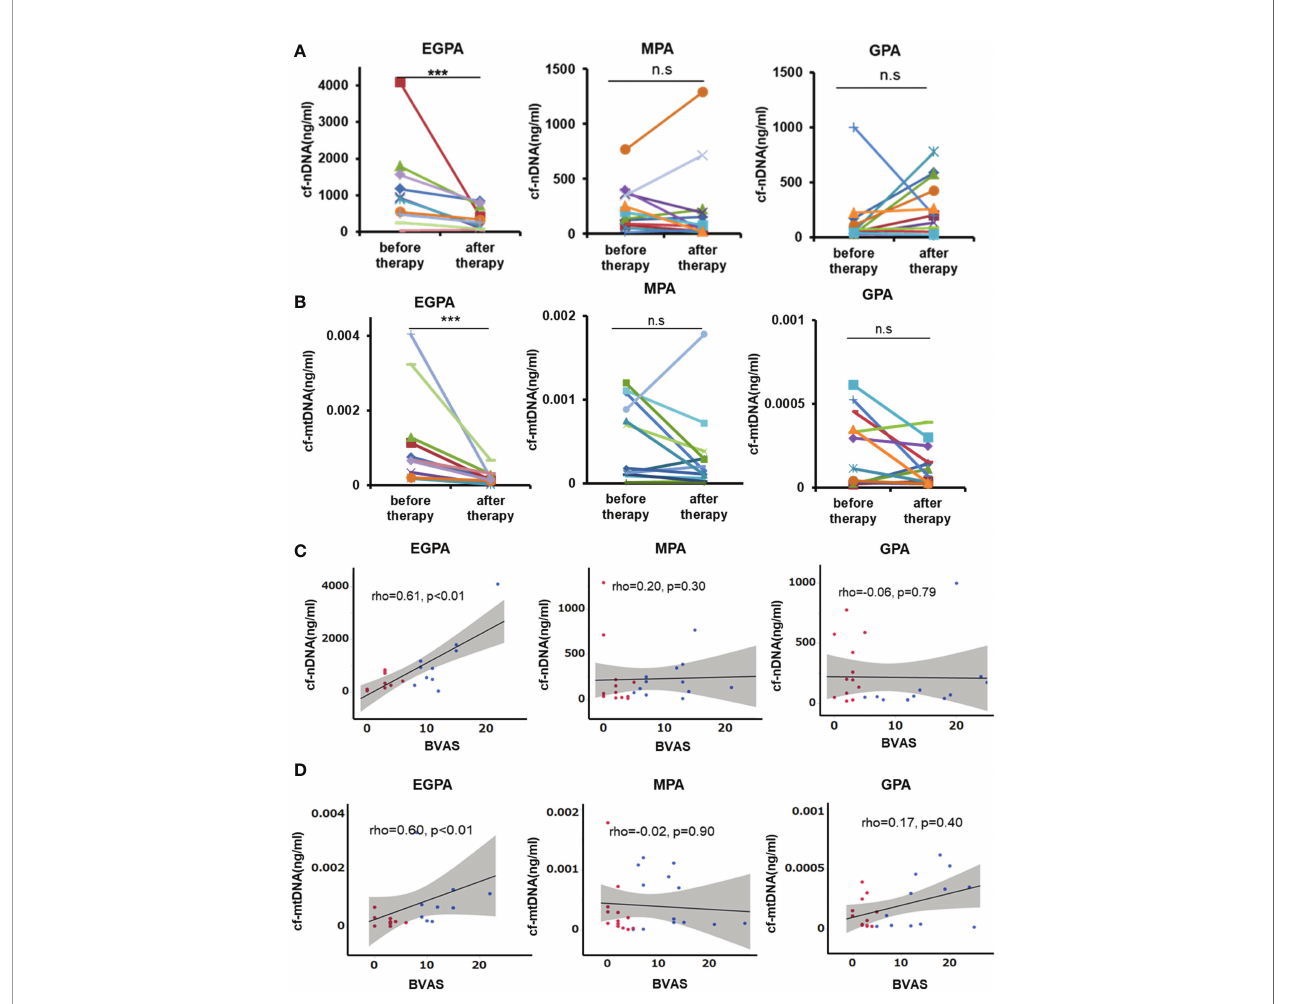
FIGURE 2 | Serum cfDNA levels and disease activity in patients with AAV. (A) Concentrations of cf-nDNA and (B) cf-mtDNA in patients with EGPA, MPA, and GPA before and after immunosuppressive therapy. Same patients connected by lines. EGPA: n=10, MAP: n=13, GPA: n=12, *** P < 0.01, ns, not signi fi cant, Wilcoxon signed rank test. (C) Correlations between serum cf-nDNA and disease activity in patients with AAV. (D) Correlations between serum cf-mtDNA and disease activity in patients with AAV. A signi fi cant correlation was only observed in patients with EGPA. Blue dots: before treatment, red dots: after treatment, straight line: regression line, gray area: 95% con fi dence interval, Spearman ’ s rank correlation coef fi